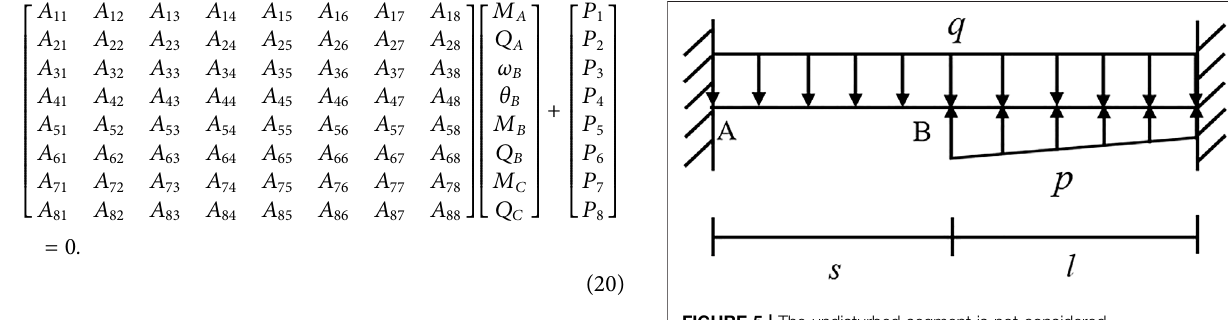
FIGURE 5 | The undisturbed segment is not